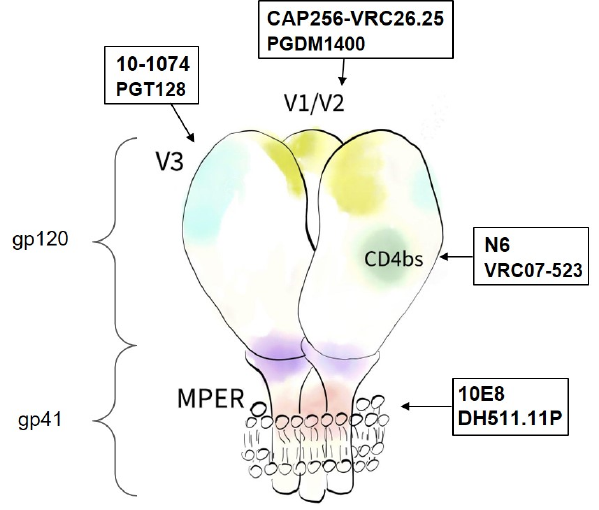
Figure 1. Schematic representation of glycoprotein Env homotrimer on the viral membrane. Each monomer consists of noncovalently bound gp120 and gp41 polyproteins. Epitopes for bNAbs are depicted in different colors. bNAbs used in this work are listed in frames.